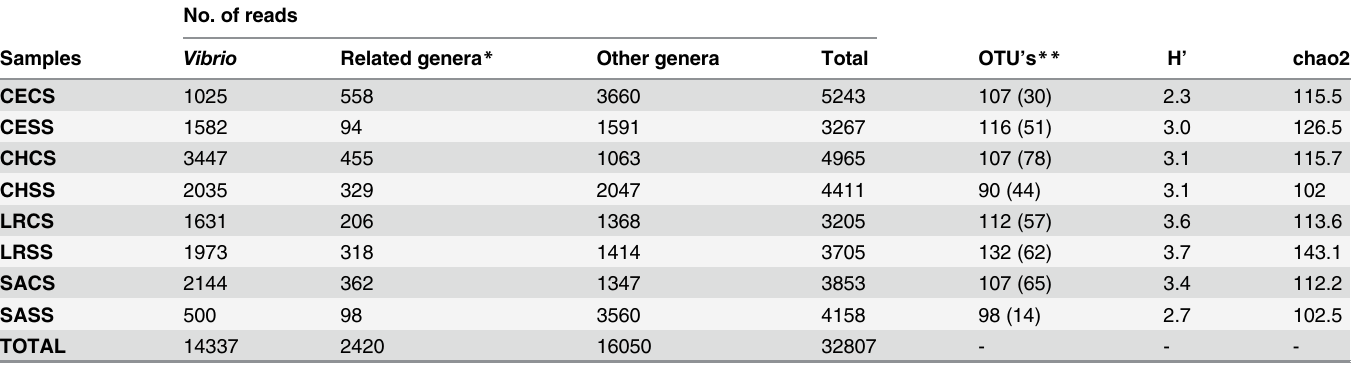
Table 1. Number of reads and diversity indexs of Vibrio spp for each composite sample. No. of